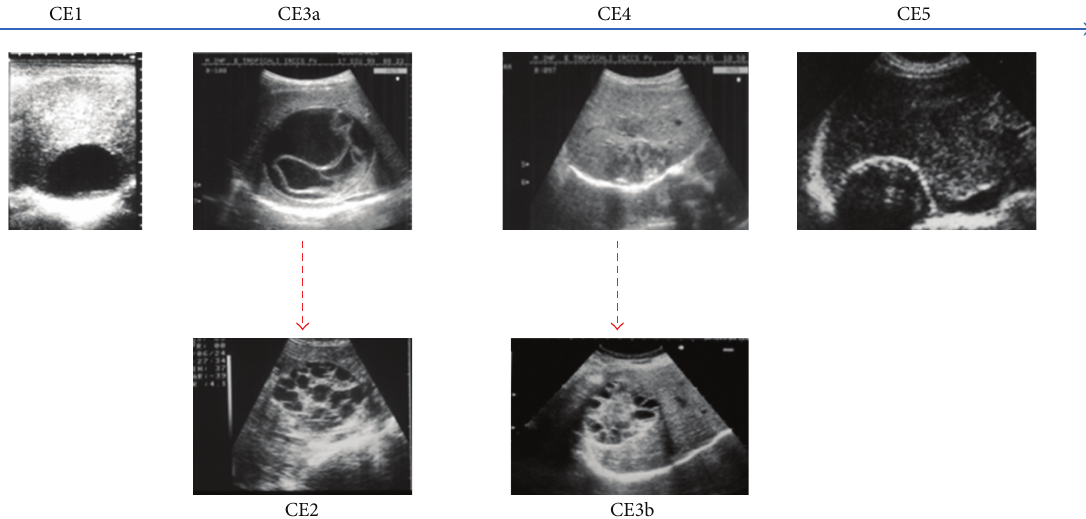
Figure 7: Cyst stages are different phases of the “natural history” of an echinococcal cyst. The upper row depicts the progressive involution (L to R) of the cyst whose cavity is gradually filled by pseudocaseous inflammatory material. Dotted lines indicate relapses from previously transitional and inactive stages, with the growth of new daughter